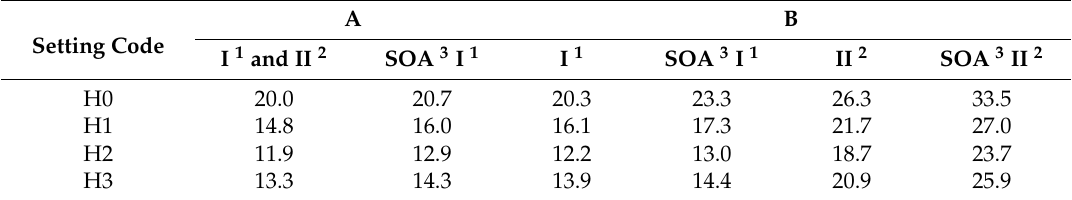
Table 8. Roll-over angles ( ◦ ) of the two tested